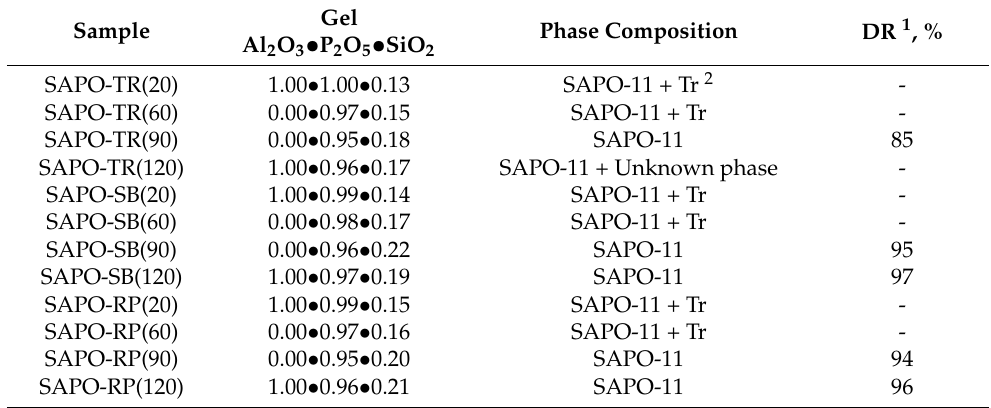
Figure 4. X-ray diffraction patterns of the crystallization products of the initial gels prepared using various boehmites: ( a ) Sample SAPO-11-TR(20); ( b ) Sample SAPO-11-SB(20); ( c ) Sample SAPO-11- RP(20). Table 4. Degree of crystallinity, chemical and phase composition of crystallization products of silicoaluminophosphate gels.